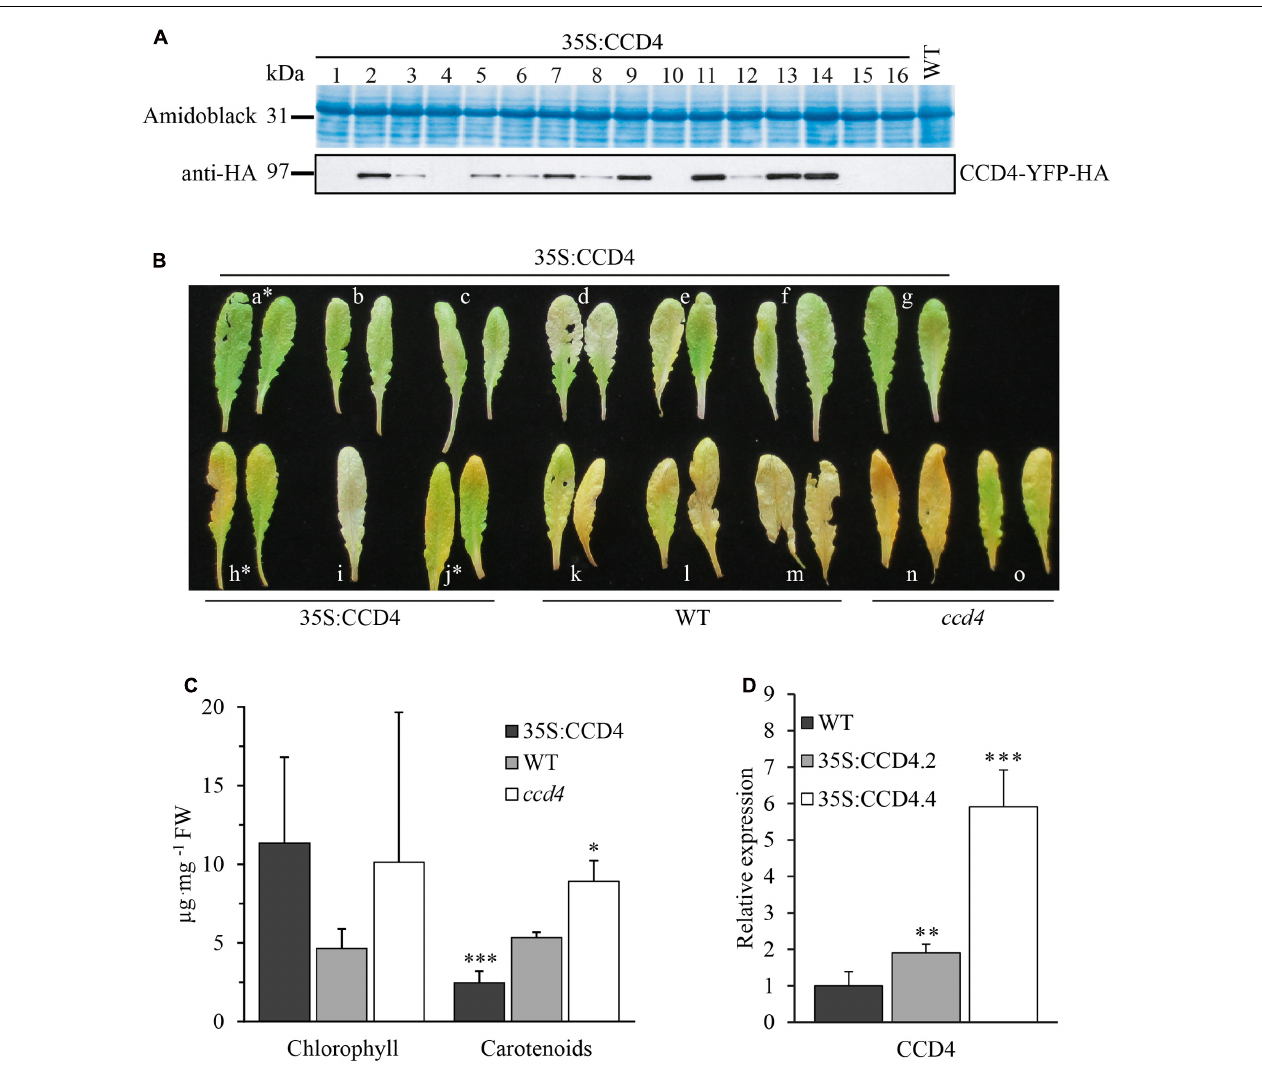
FIGURE 3 | Complementation of ccd4 mutants with 35S:CCD4-YFP-HA. (A) Relative amounts of CCD4-YFP-HA in complemented lines were assessed by immunoblot analysis with anti-HA antibodies. A representative blot of 16 independent lines is shown, none of which showed a visible phenotype. (B) Complementation analysis of CCD4 complemented lines by dark-induced senescence. Detached leaves were subjected to dark-induced senescence for 10 days and complementation was determined based on the phenotype. Two 35S:CCD4 plants (h and j) were not complemented as they showed a yellowish color similar to ccd4-4. (C) Total chlorophyll and carotenoids were extracted from the leaves shown in (B) (NB: the white asterisks mark the leaves that were excluded for the calculations). Concentrations of pigments were established with a spectrophotometer. Means ± SD were calculated for CCD4 complemented plants ( n = 7), WT (n = 3) and ccd4 (n = 2). Statistical significance was determined by a Student’s t -test (unpaired homoscedastic, two-tailed, ∗ P < 0.05, ∗∗∗ P < 0.001). (D) CCD4 gene expression analysis. Transcripts of CCD4 were quantified by qPCR in the WT and in the two complemented lines, i.e., 35S:CCD4.2 and 35S:CCD4.4. The relative expression of CCD4 was normalized to the reference gene ACTIN . Means ± SD ( n = 6). Statistical significance between transgenic lines and the WT was determined by a Student’s t -test (unpaired heteroscedastic, two-tailed, ∗∗ P < 0.01, ∗∗∗ P <